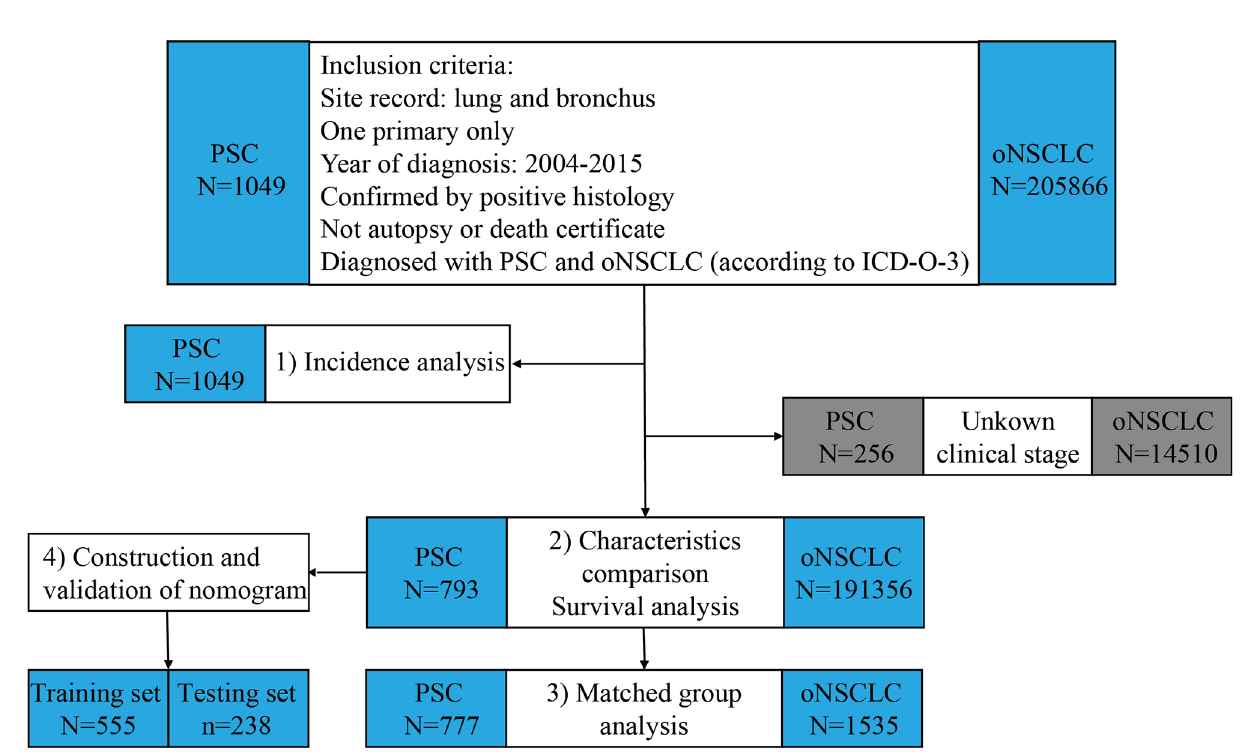
FIGURE 1 | Flowchart of study design and patient selection. PSC, pulmonary sarcomatoid carcinoma; oNSCLC, other non-small-cell lung